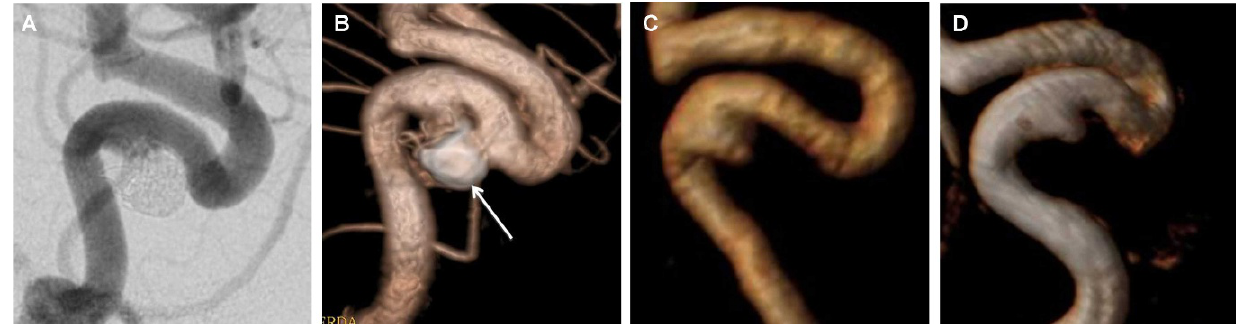
Figure 1 - Post-embolization follow-up of a cavernous carotid artery aneurysm, in working-view incidences, classified in consensus by both readers as class II in Raymond scale. A: DSA of the internal carotid artery showing the residual neck of the treated aneurysm (class II). B: DSA with 3D reconstruction delimiting the aneurysm residual neck (class II) and the coil mesh (arrow). C: CE-MRA with volume- rendered reconstruction showing class II recanalization. D: TOF-MRA with volume-rendered reconstruction showing class II recanalization.